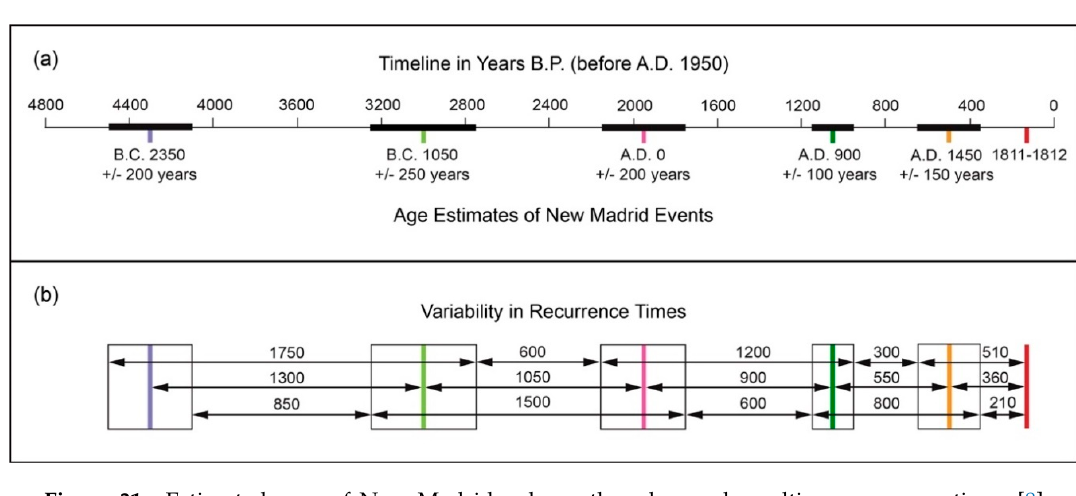
Figure 31. Estimated ages of New Madrid paleoearthquakes and resulting recurrence times [8] (modified from Reference [6]): ( a ) timeline showing timing of New Madrid events during past 4500 years; ( b ) uncertainties in timing of New Madrid events lead to variability in estimates of recurrence times. Average recurrence time for two most recent earthquake cycles is ~500 years and ~1100 years for three earlier earthquake cycles.